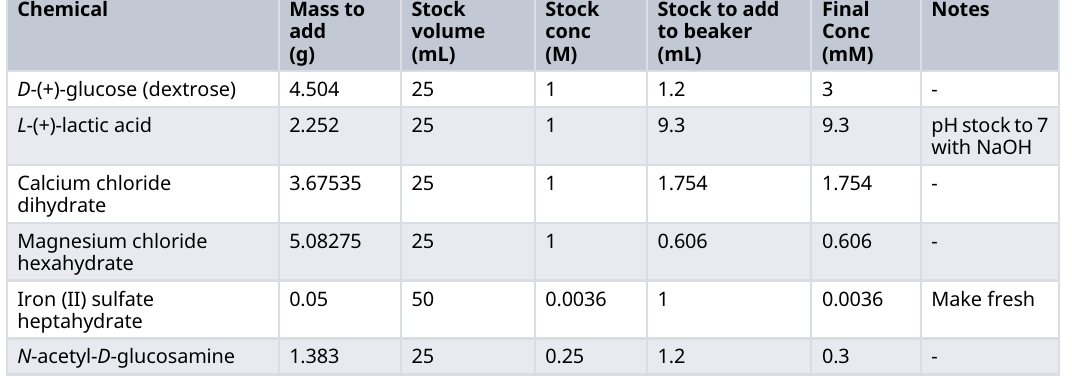
Table 5. Reagents to make 1 L ASM after addition of the mucin-DNA solution and pH adjustment to pH 6.8.